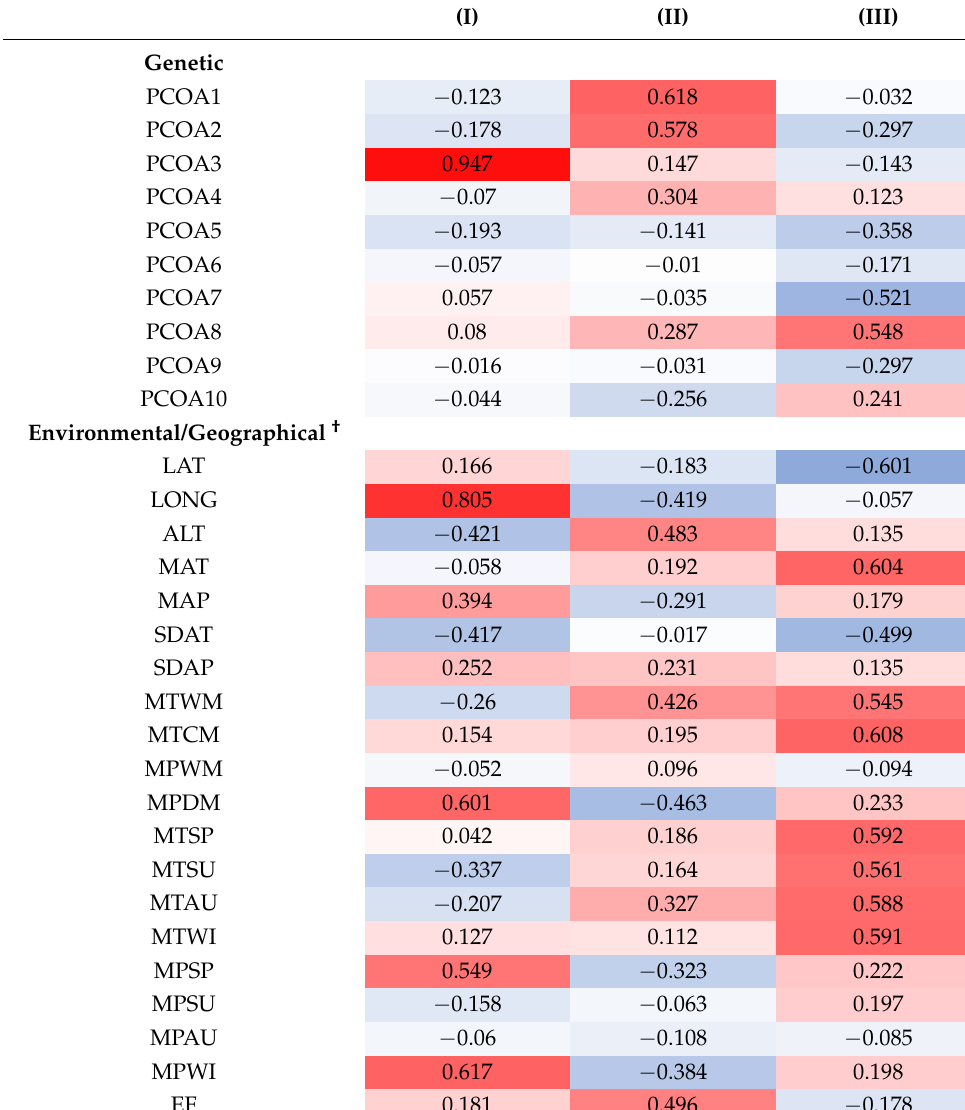
Table 4. Canonical correlation analysis of the PCOA and environmental/geographical variables in prairie cordgrass natural